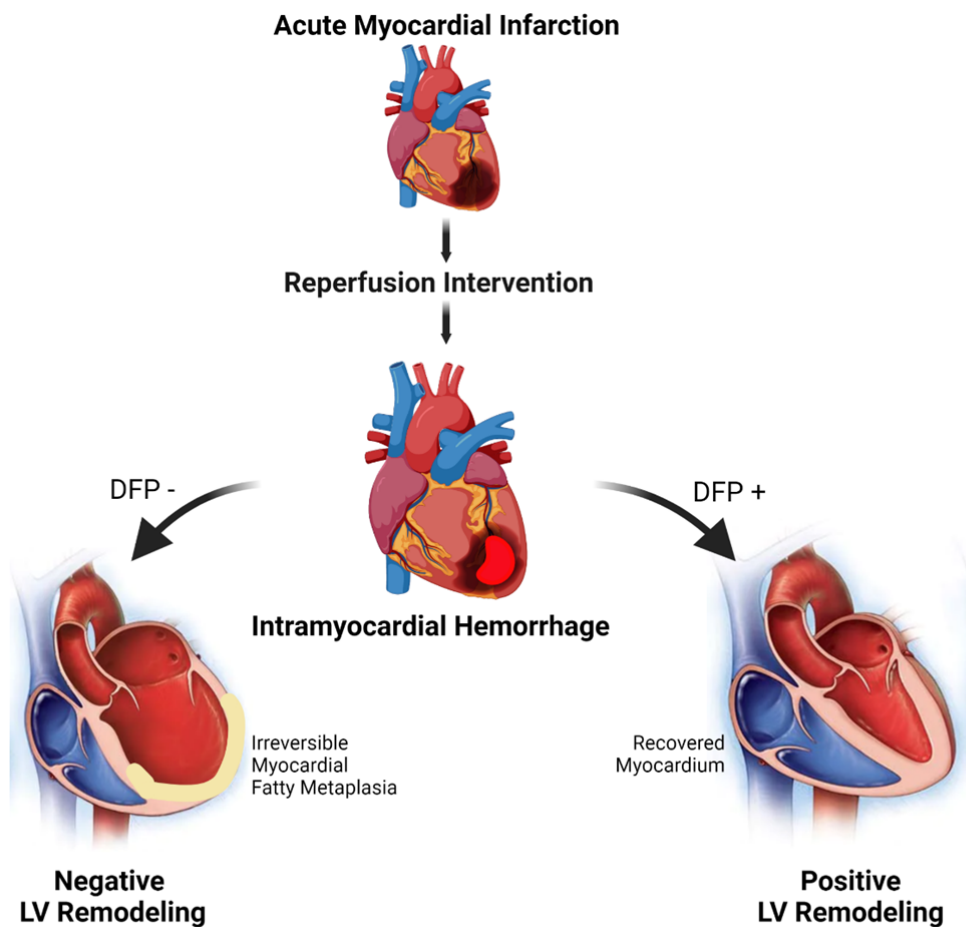
FIGURE 3: Schematic of differential LV remodelling post hemorrhagic MI with and without oral administration of deferiprone. Iron depos- its from post-reperfusion intramyocardial hemorrhage drives the negative ventricular remodeling mechanistically towards fatty degenera- tion. However, intervention of deferiprone disrupts the iron-mediated degeneration and drives the heart towards positive remodeling. The area of MI is shown as black area on left ventricle in the top image, intramyocardial hemorrhage is shown as red area on image second from the top; negative left-ventricular remodeling is depicted by dilated left ventricle on DFP- image with semicircular white area representing lipomatous metaplasia; DFP+ image is shown with normal sized LV. Figure was generated using